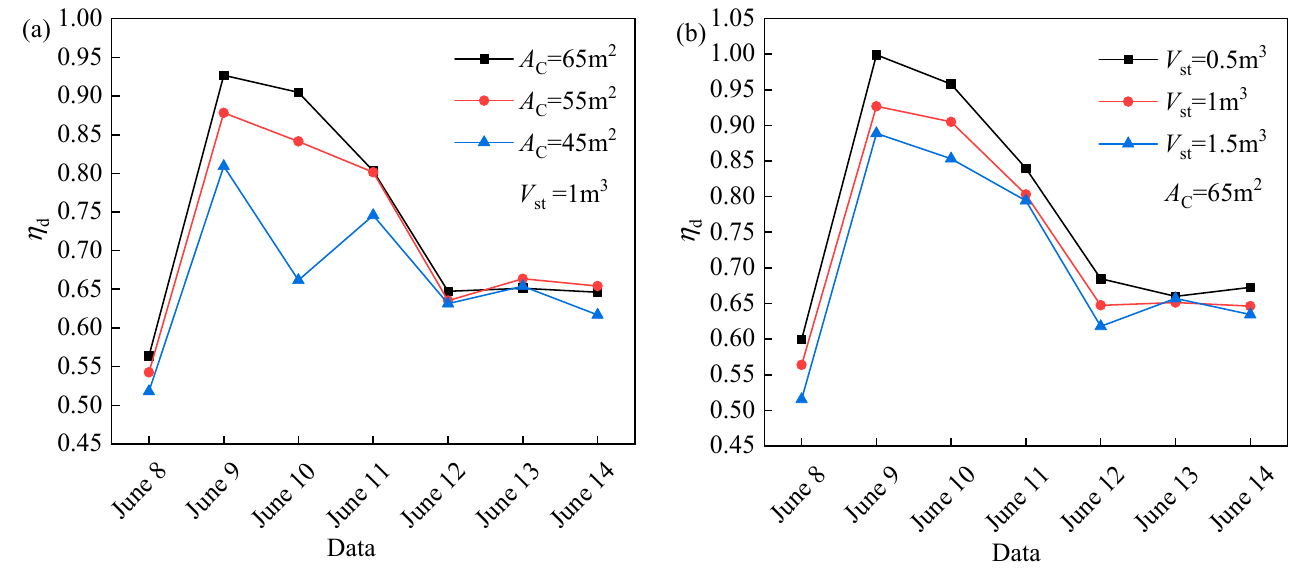
Figure 3. Variation in daily cooling efficiency with collector area and storage tank volume ( a ) collector area ( b ) storage tank volume.